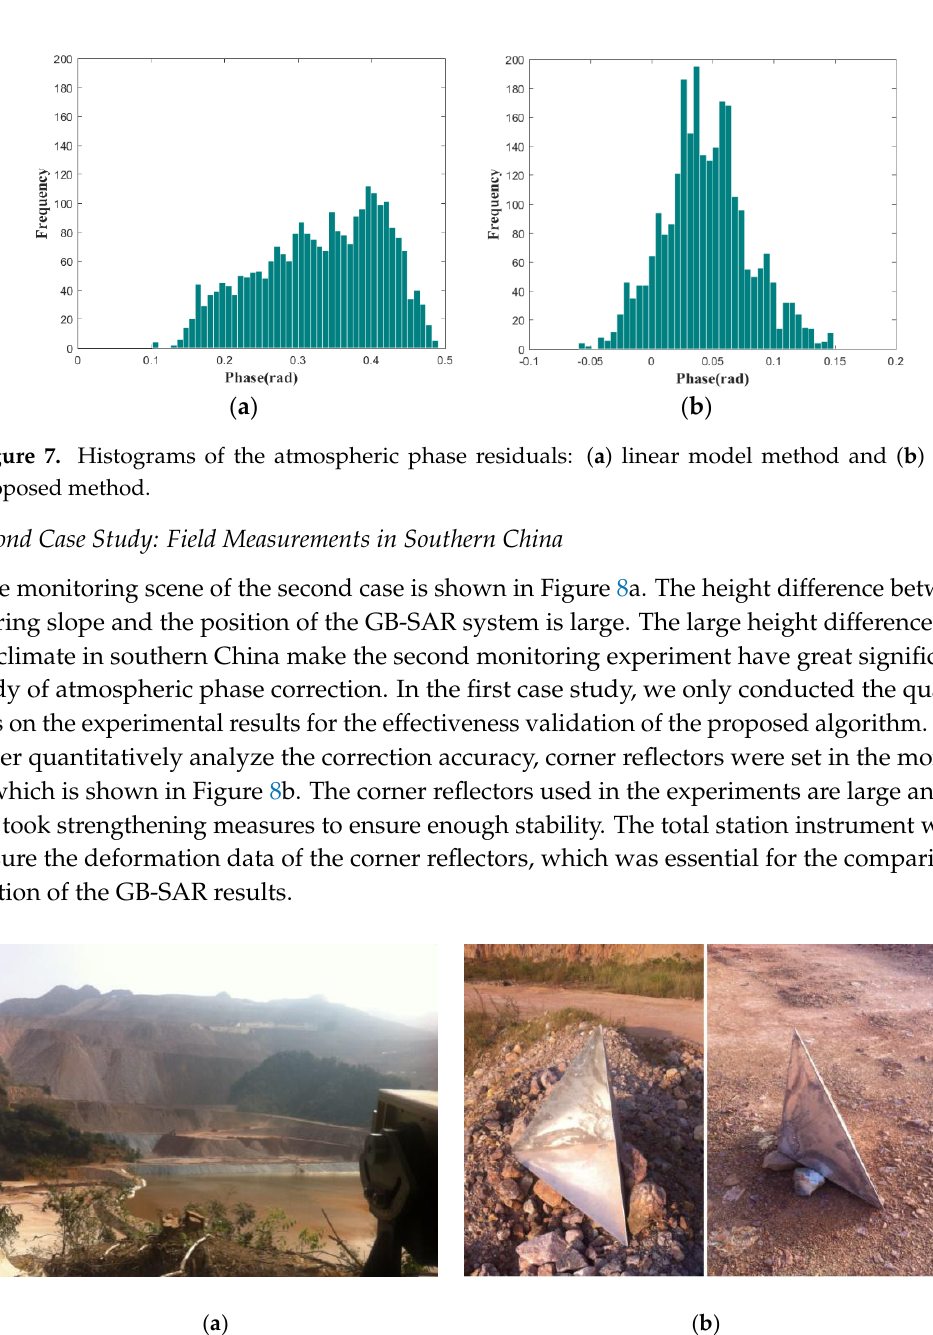
Figure 8. Deformation monitoring for case study 2: ( a ) the monitoring scene and ( b ) corner reflectors.